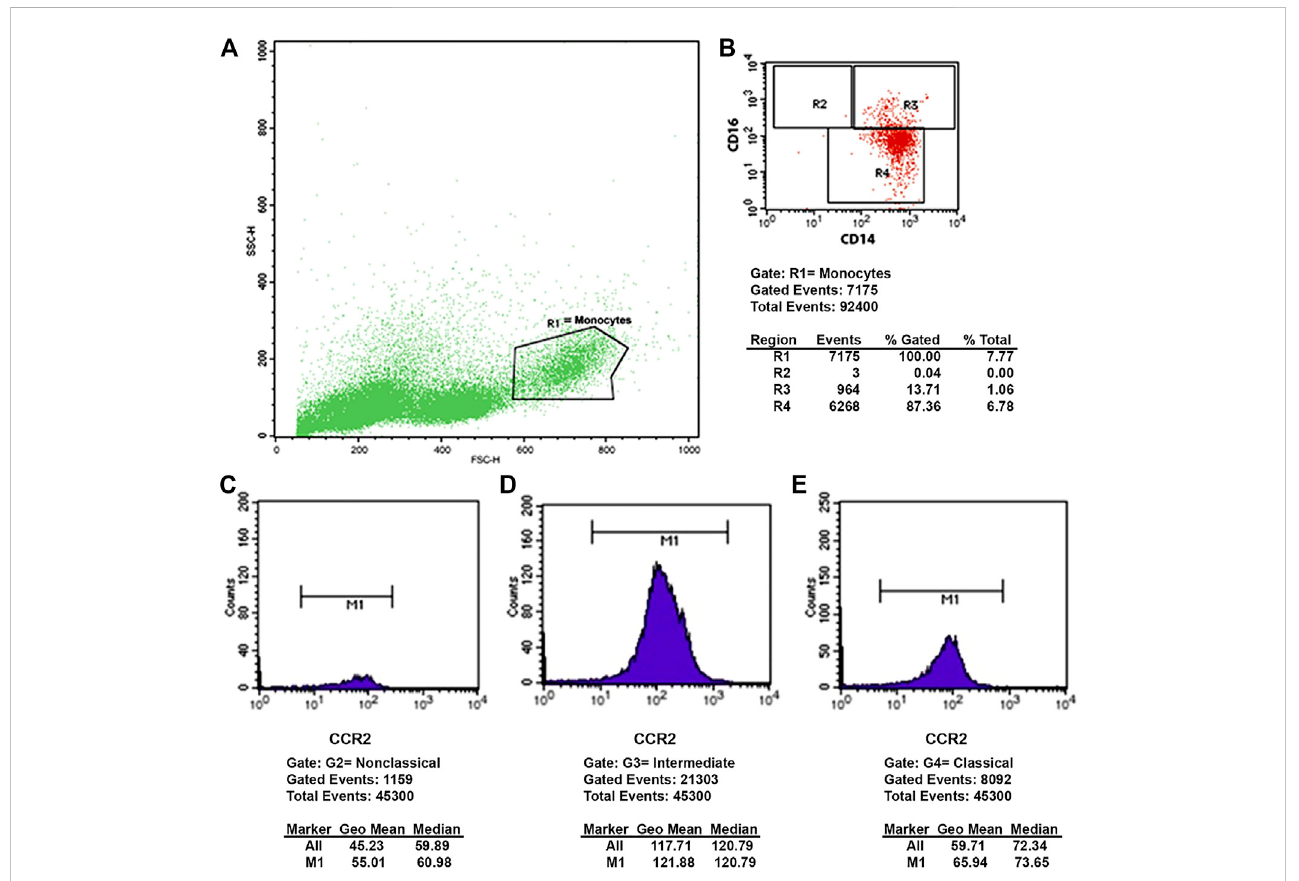
FIGURE 1 Flow cytometry plot. (A) Size (FSC-H) and complexity (SSC-H) graph, showing the mononuclear cells and the monocyte gate (R1). (B) Fluorescence graph, showing: R2 non-classical (CD14+CD16++), R3 intermediate (CD14++CD16+) and R4 classical (CD14++CD16 − ) monocyte subtypes. (C – E) Histograms representing the expression of CCR2 in non-classical (C) , intermediate (D) and classical (E)